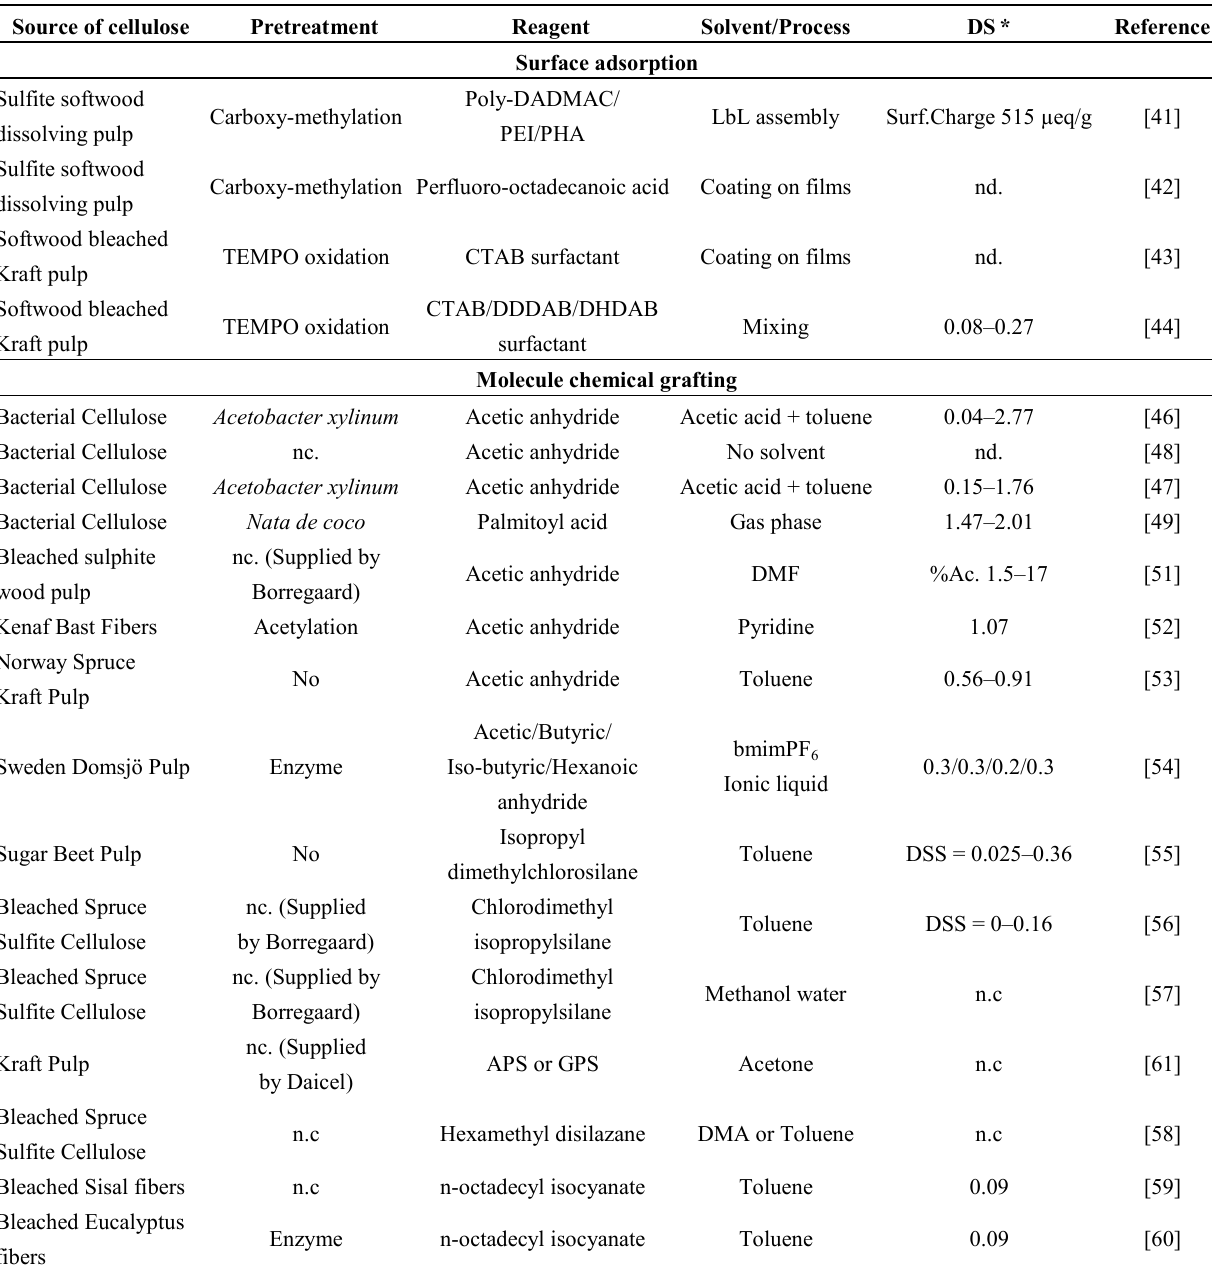
Table 1. All physical and chemical strategies used to impart grafting onto Nanofibrillated Cellulose